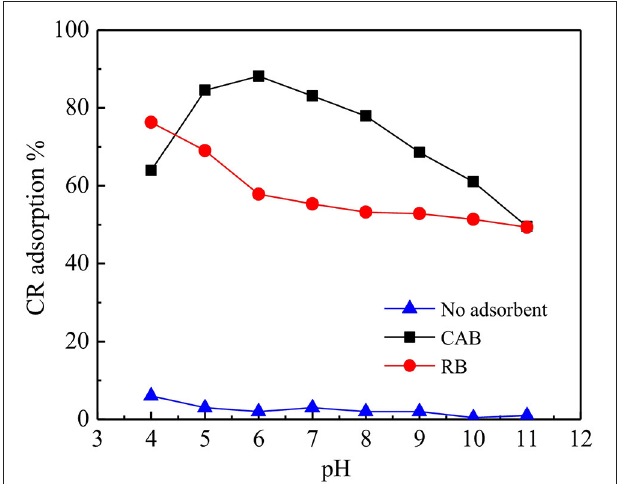
FIGURE 5 | Effect of pH on CR adsorption on RB and CAB.